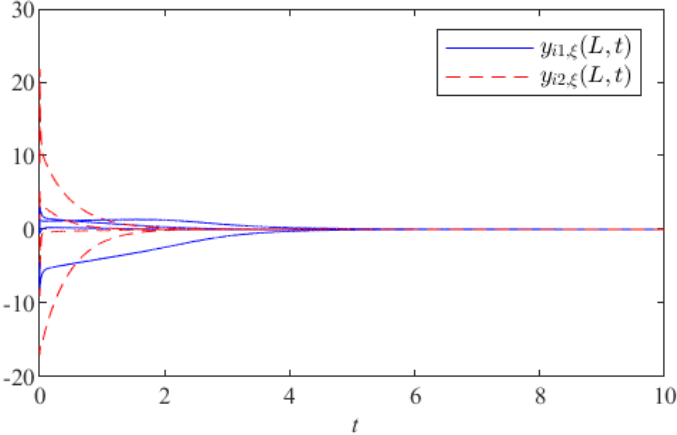
Figure 4. The boundary coupling y i ( L , t ) in Example 1.